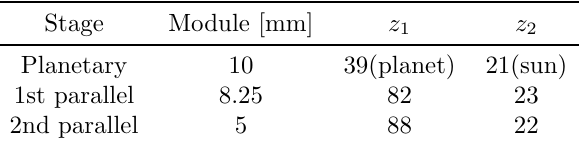
Table 4: Basic gearbox data